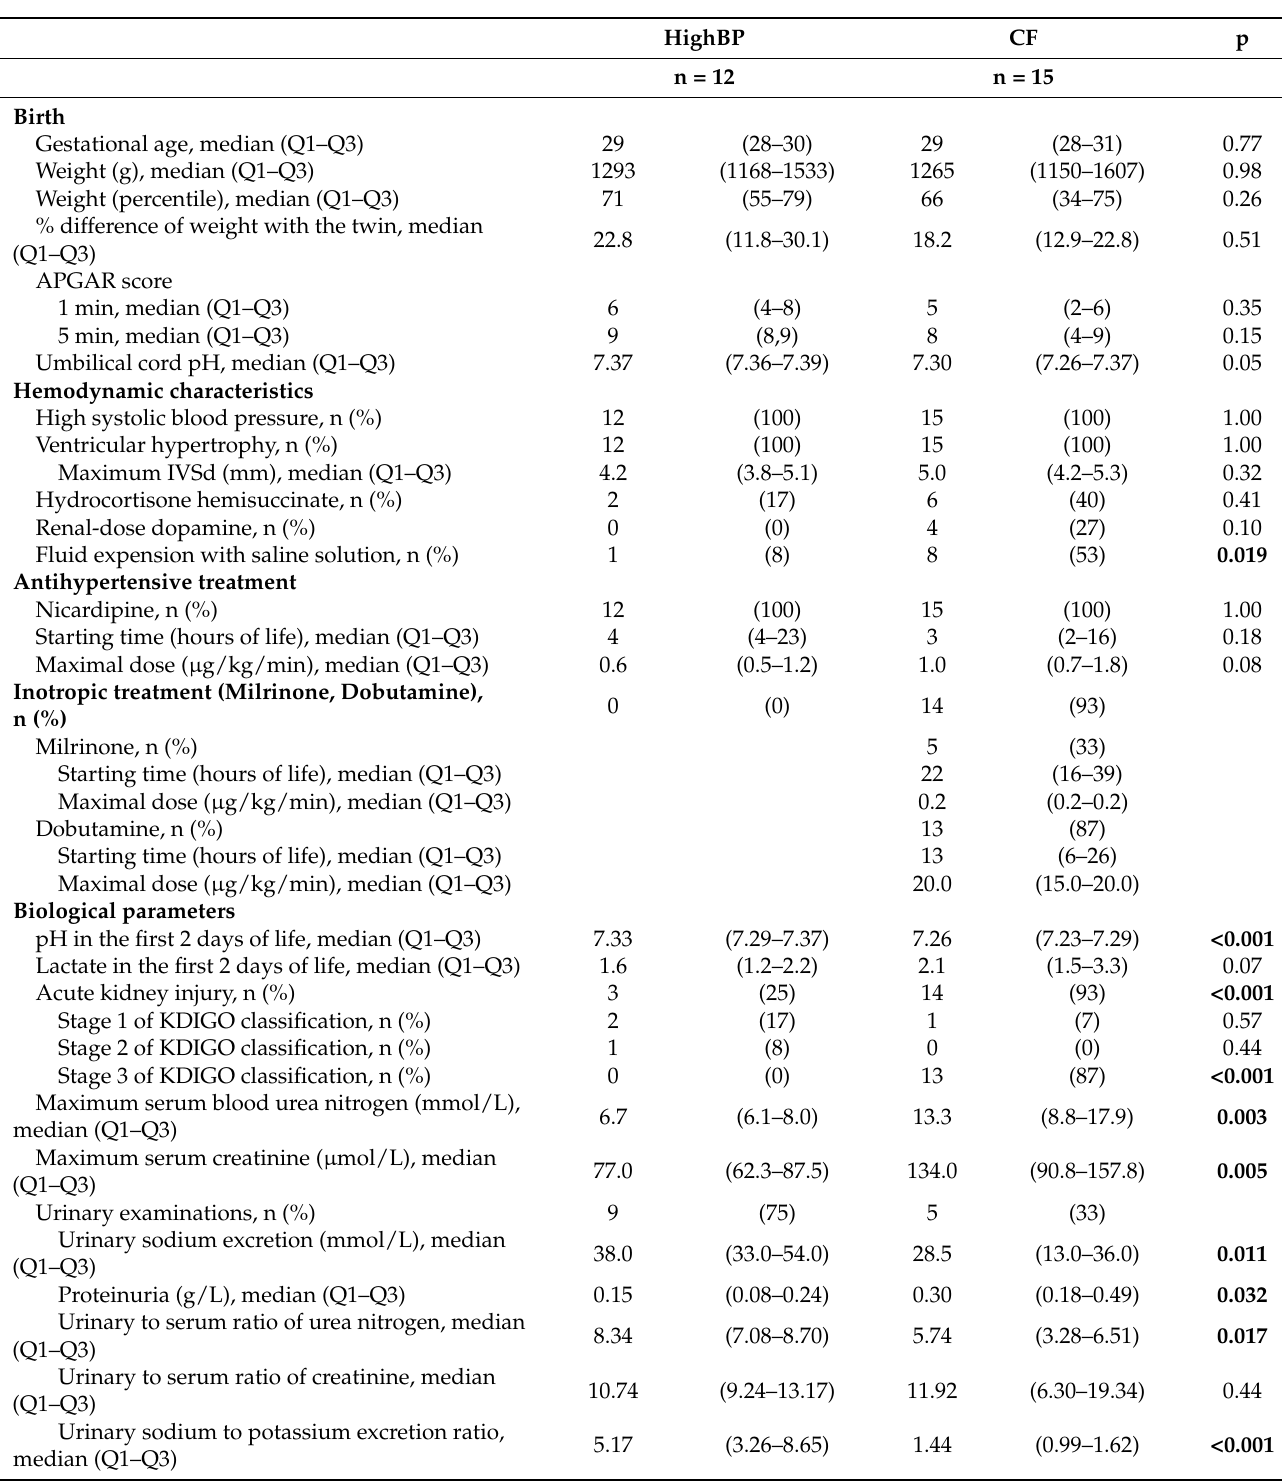
Table 2. Comparison of hemodynamic characteristics between the high blood pressure (HighBP) group and the cardiac failure (CF) group. IVSd: Interventricular septum